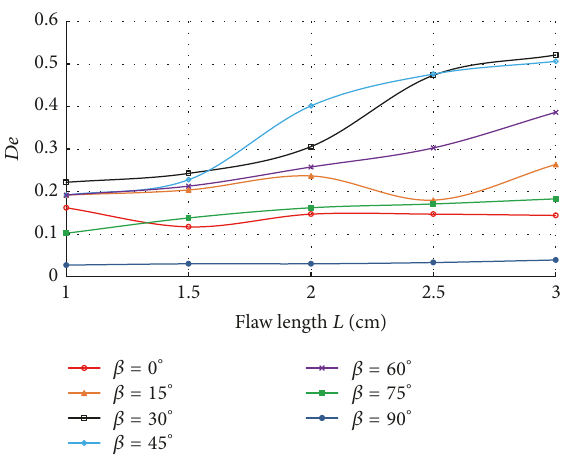
Figure 8: Reduction degrees for the peak strengths of model containing single